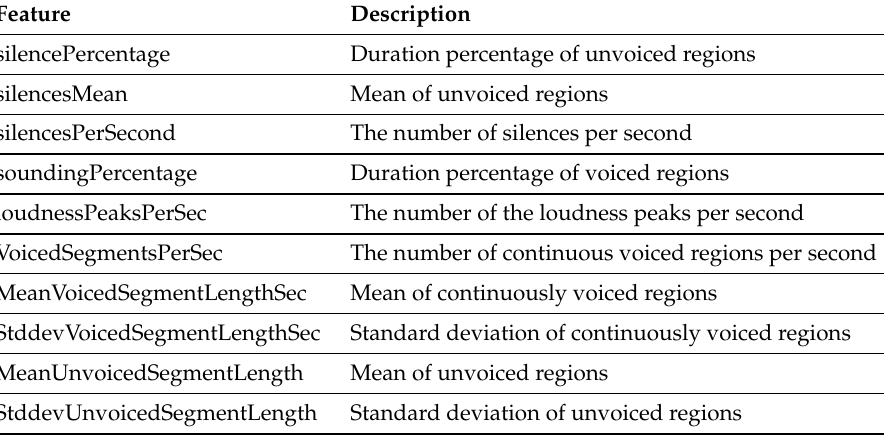
Table A3. Temporal features explained. The first four features are not included in the eGeMAPS feature